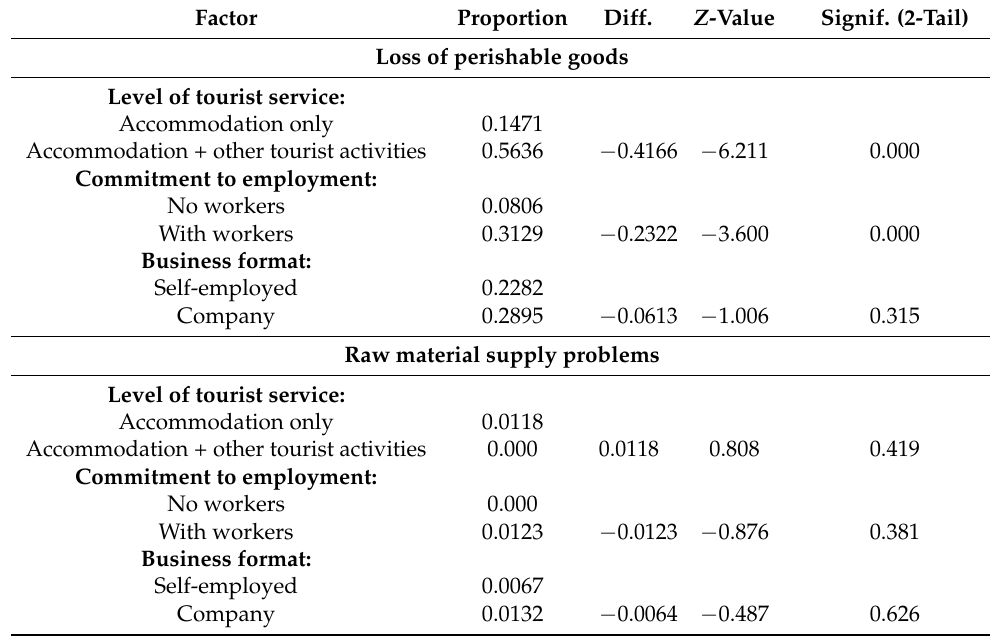
Table 6. Comparison of proportions of the effects of the COVID-19 lockdown on the tourism management of tourist accommodation D: input